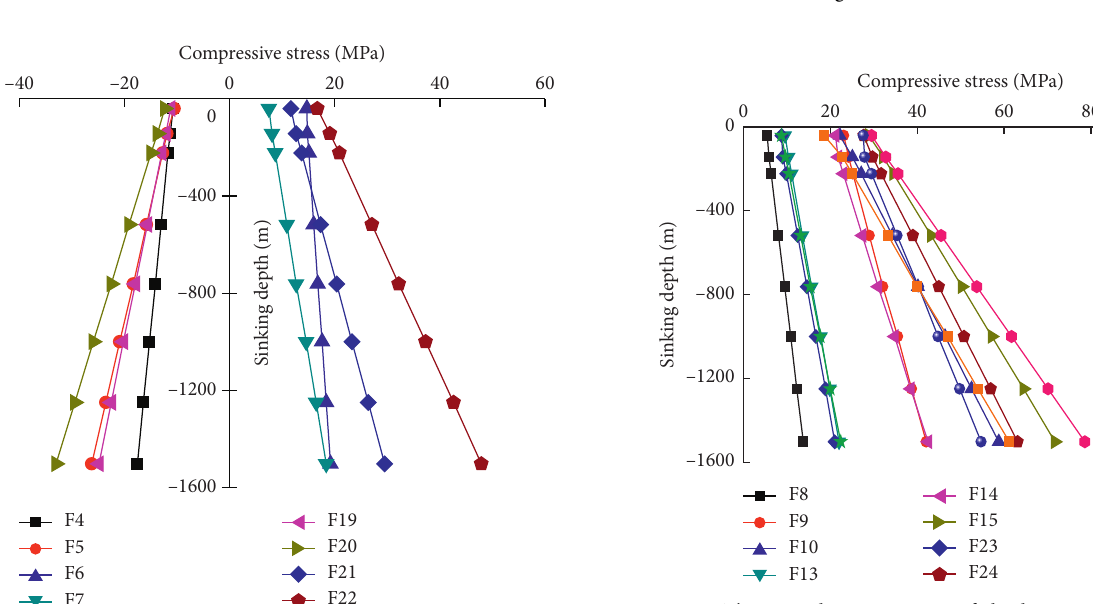
Figure 8: Theoretical stress curves of the lower corner column under different working conditions.